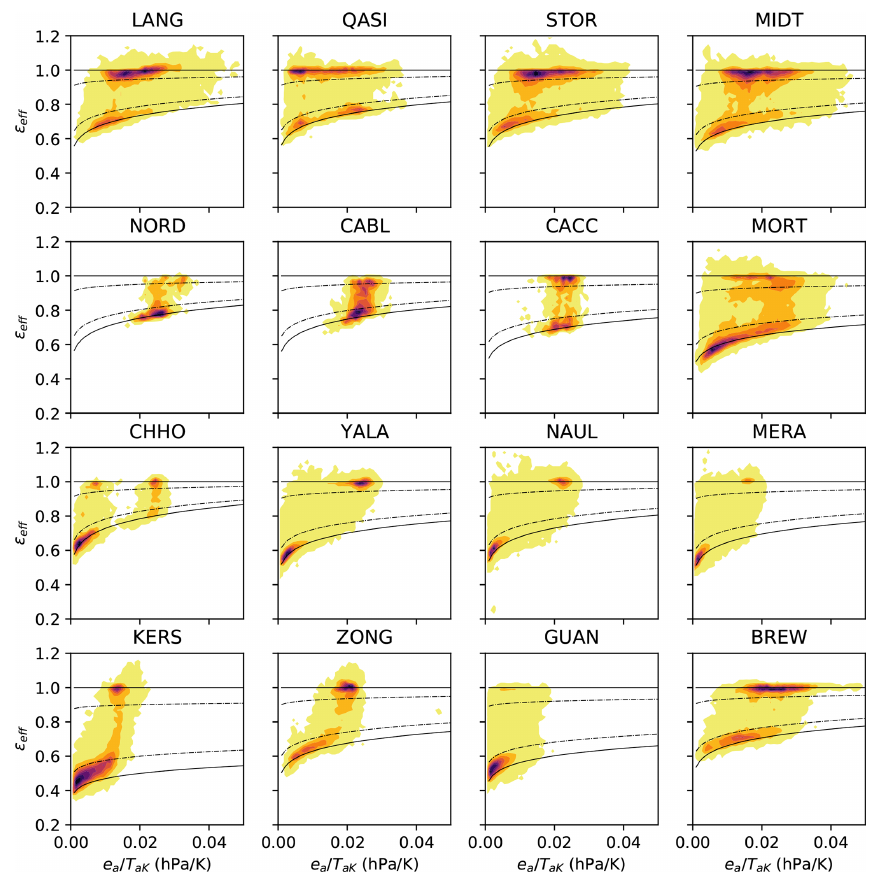
Figure 4. Frequency of observed ε eff (filled contours) vs. e a /T a , K for sites arranged by latitude. Also shown are calculated ε cs (lower solid line), ε ov (upper solid line) and ε eff at clear-sky and overcast limits of N ε = 0 . 2 and N ε = 0 . 8, respectively (lower and upper dashed lines, respectively). Contours of relative frequency created from 2D histogram with common x and y bins across all sites with colours in 10 steps between 1 (yellow) and the maximum number of hours in any x , y bin for each site (dark